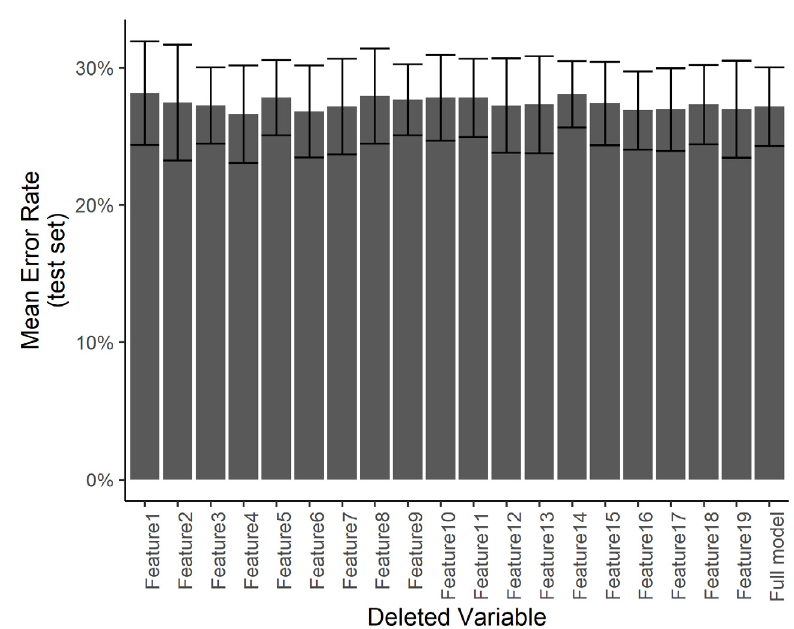
Figure 12. Effect of individual features. The test error for the predicting of the specific treatment plan using the neural network after independently deleting single features from the dataset.